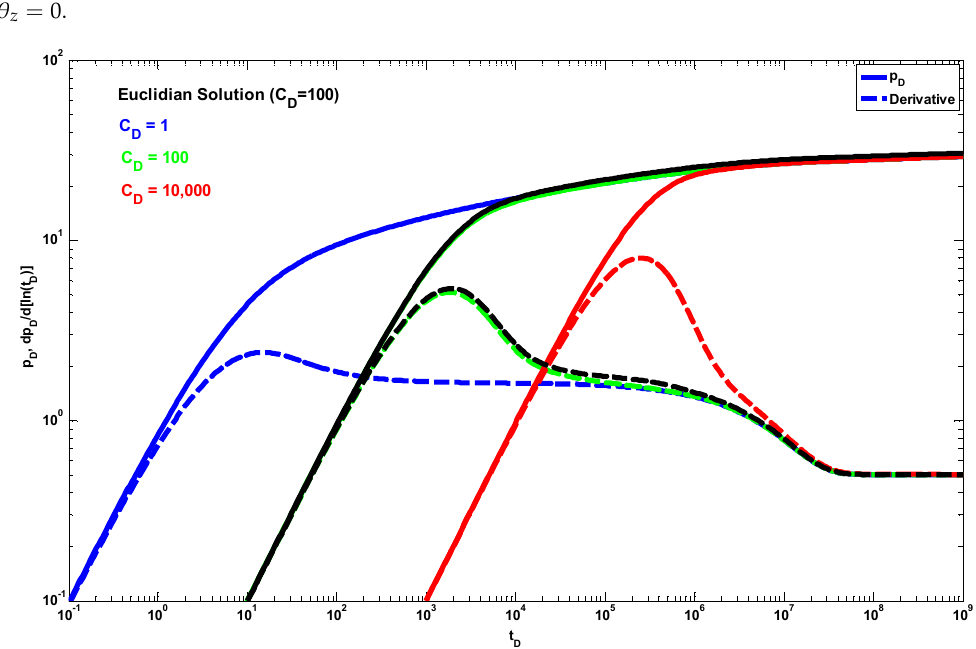
Figure 5. Euclidean case: z wD = 0, h D = 10,000, h pD = 0.3, S = 1, ε = 1, d fr = 2, θ r = 0, d fz = 1, θ z = 0 .